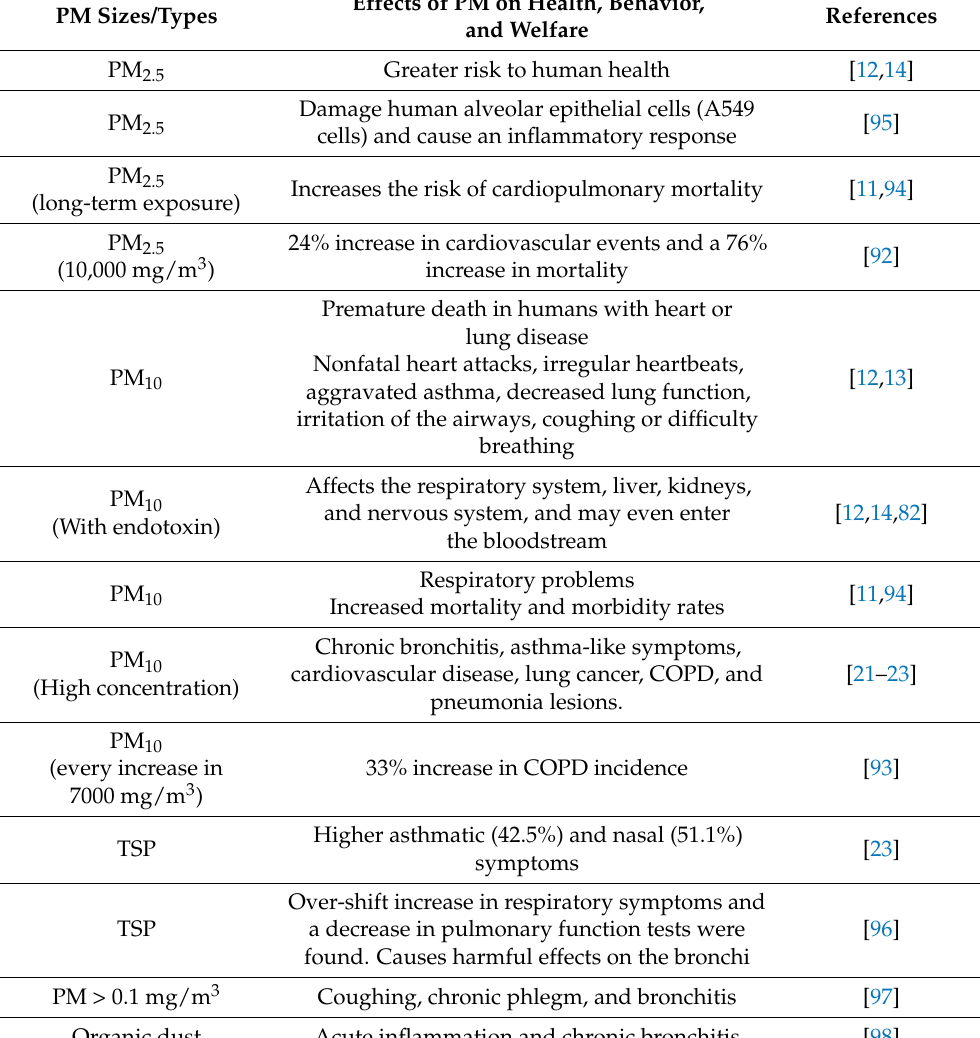
Table 7. Effects of different PM sizes on health, behavior, and welfare of